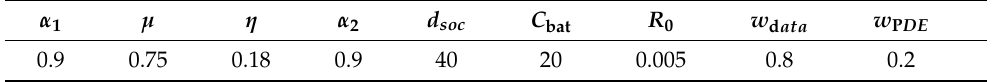
Table 4. Default values of the nine main fractional-order